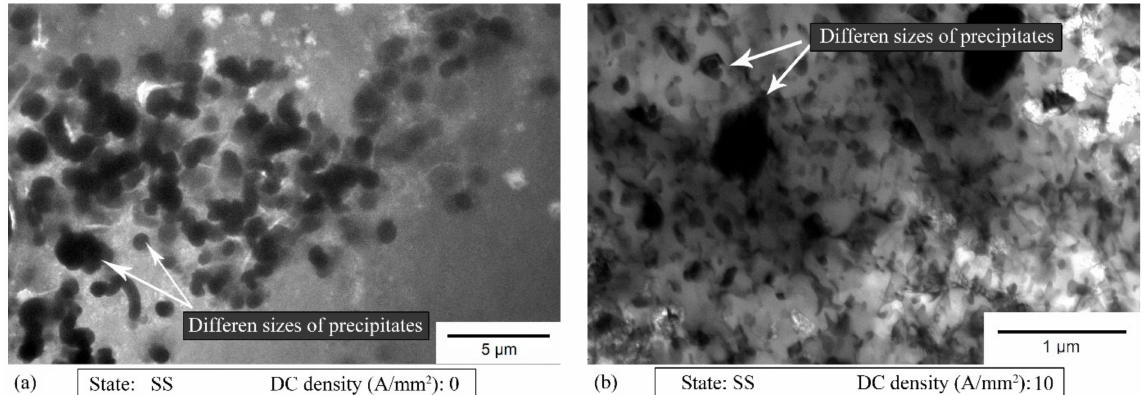
Figure 10. TEM bright-field images of the specimen strained to its maximum uniform strain without current ( a ) and with 10 A/mm 2 density current application ( b ).